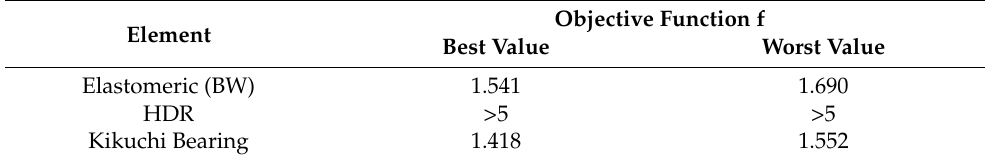
Table 9. Estimated best and worst objective function values obtained applying the DE